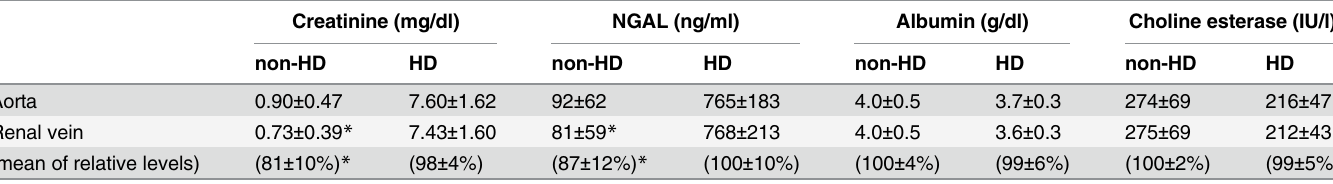
Table 4. Comparison of plasma levels of markers in aorta and renal vein among patients who underwent coronary angiography.